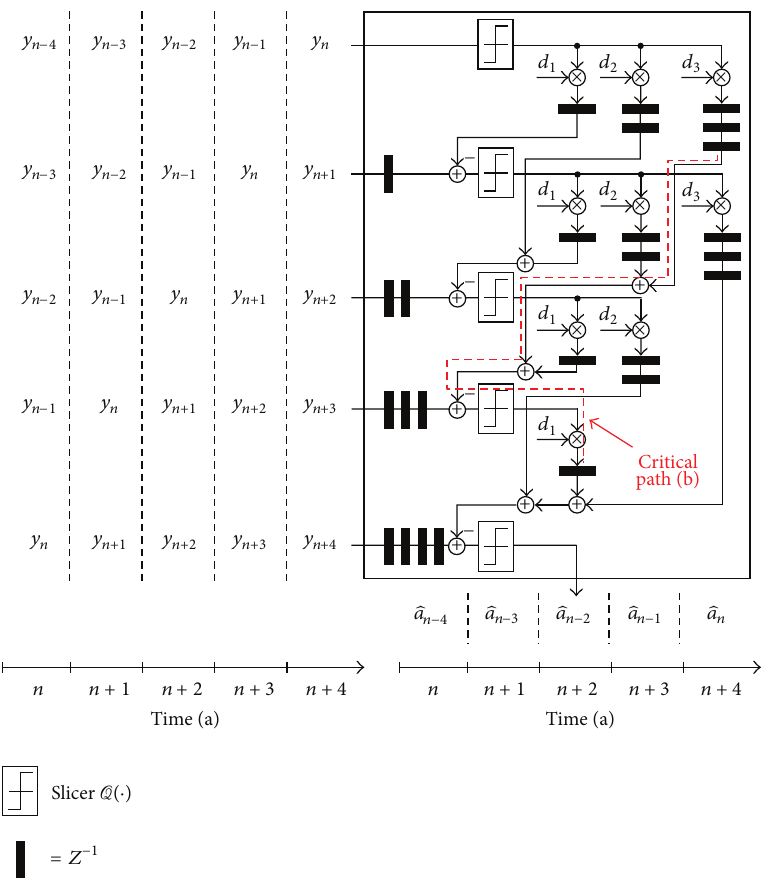
Figure 1: Example of a 3-tap DFFE ( 𝐿 = 3 ) with 𝑅 = 5 . (a) Note that the latency between the input signal and the decision is 𝑅 − 1 . (b) The red dashed line denotes the critical path (see Section